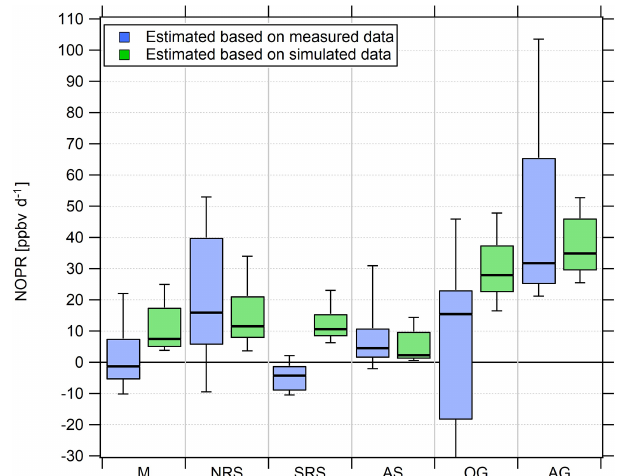
Figure 9. Diurnal net O 3 production rates in the different regions. Due to the magnitude of the pollution sources, the lower whisker of the NOPR estimate over the Oman Gulf is − 324ppbd − 1